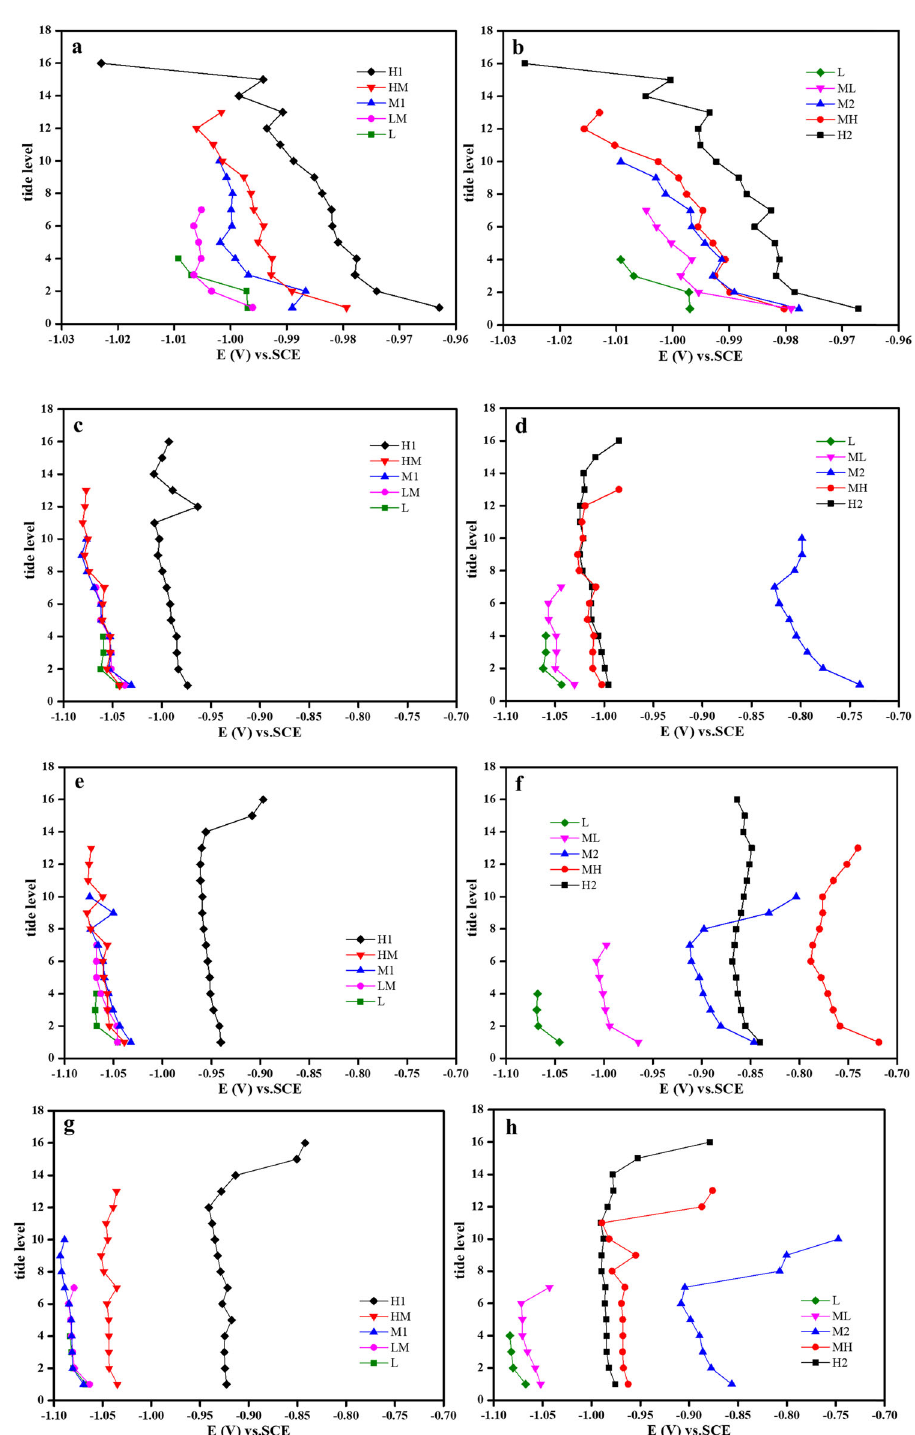
Fig. 4 Average potential distributions. Average potential distributions of a single row of fi ve electrodes at different tide levels on a , b 1st, c , d 15th, e , f 23rd, and g , h 40th day of For 3-1#, although the impedance arc associated with the deposited layer was detected in the high-frequency region of the impedance spectrum acquired on the 8th day, the initial growth of the deposited layer was slow and the impedance was still less than 50 Ω cm 2 at 15 days (Fig. 10a). The low initial impedance and slow growth of the deposited layer in the full immersion zone may be related to the precipitation of H 2 during